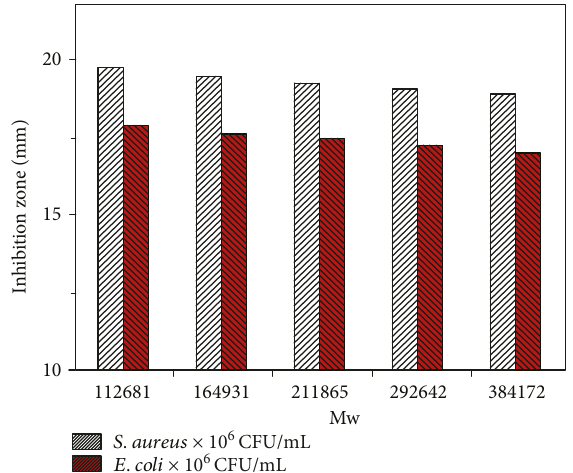
Figure 5: In fl uence of Mw of gelatin on antimicrobial activity.